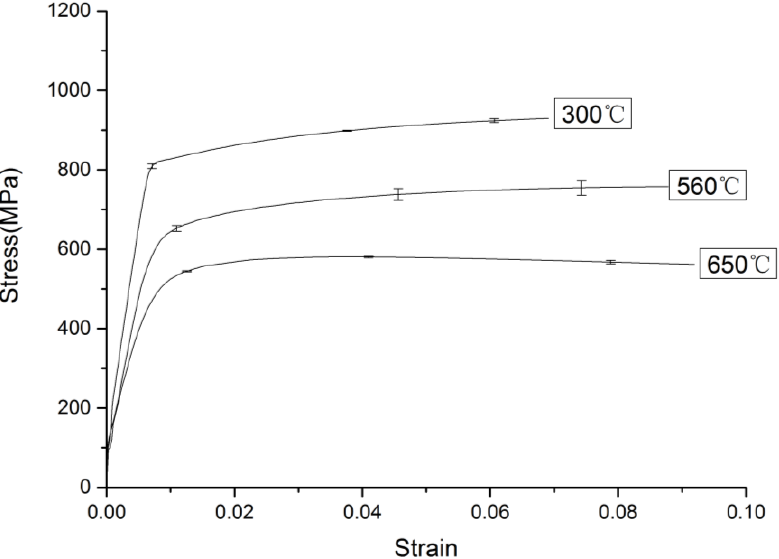
Figure 3. Stress-strain curves for the TiC/TMCs composites under quasi-static tensile at different temperatures.